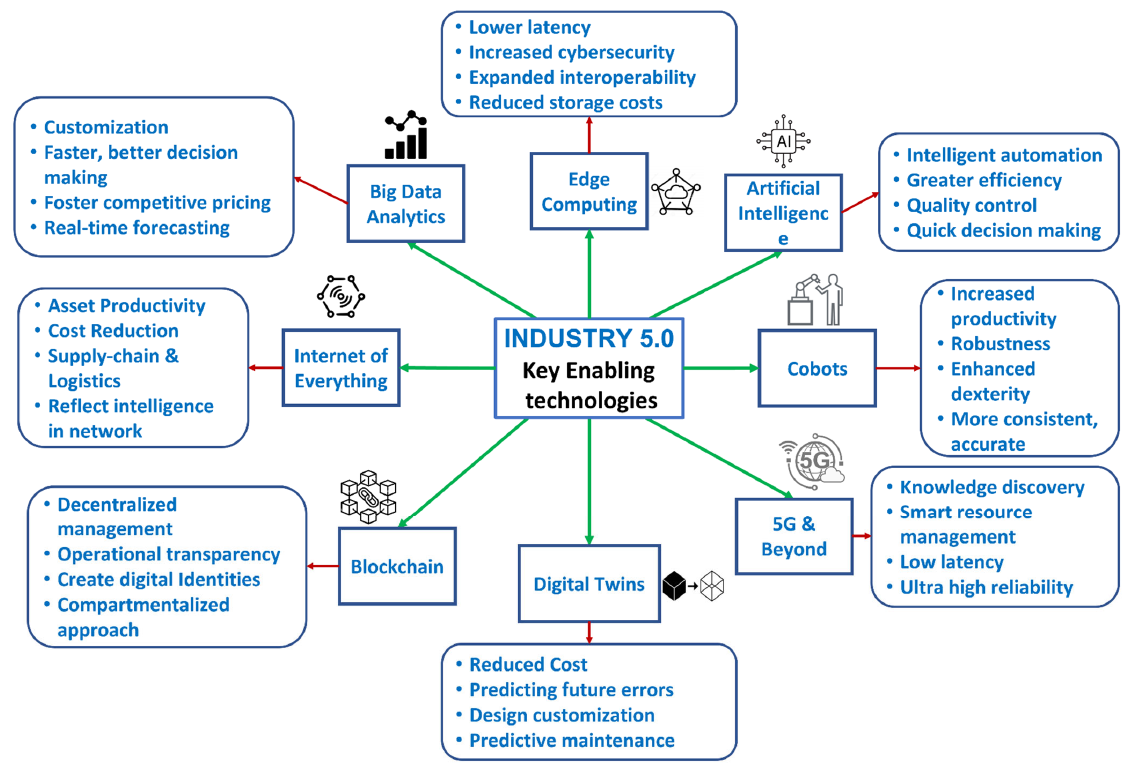
Figure 11. Key Enabling Technologies in the transition from Industry 4.0 to Industry 5.0 (derived from [40]).